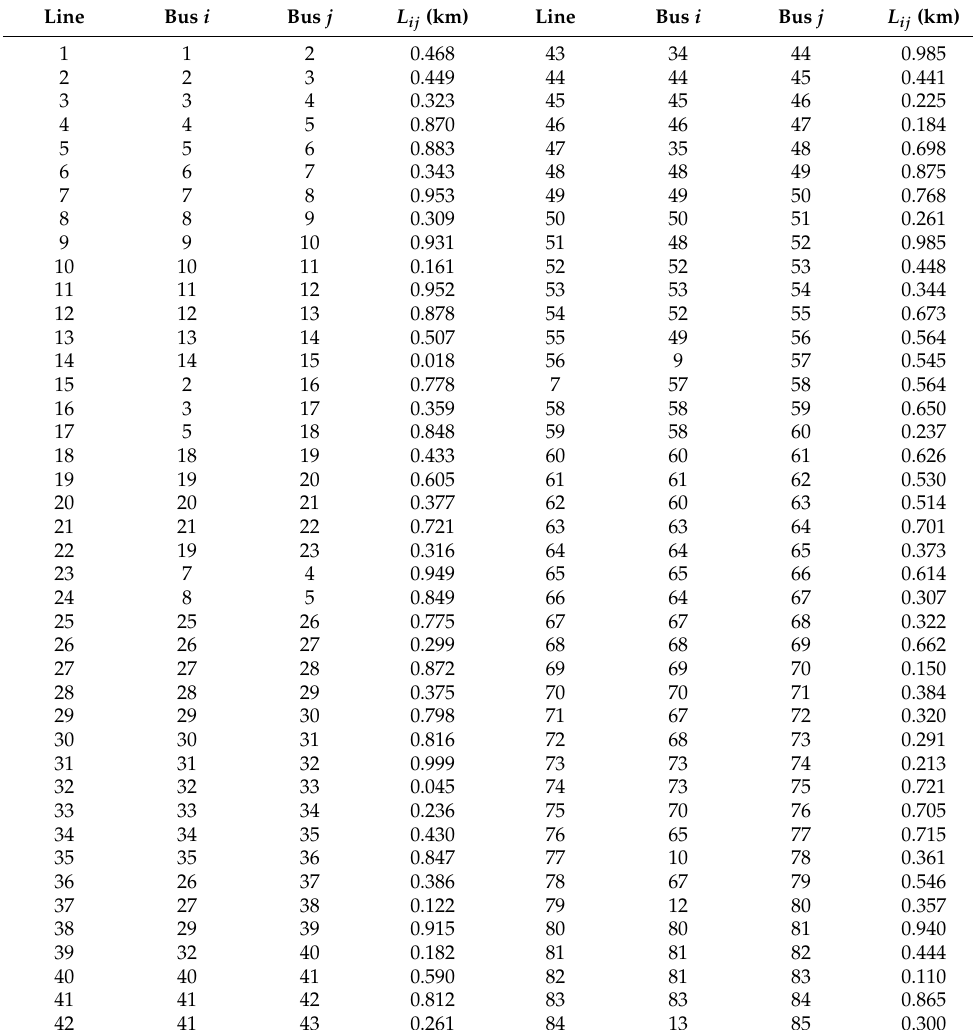
Table 13. Line connections and their lengths for the IEEE 85-bus